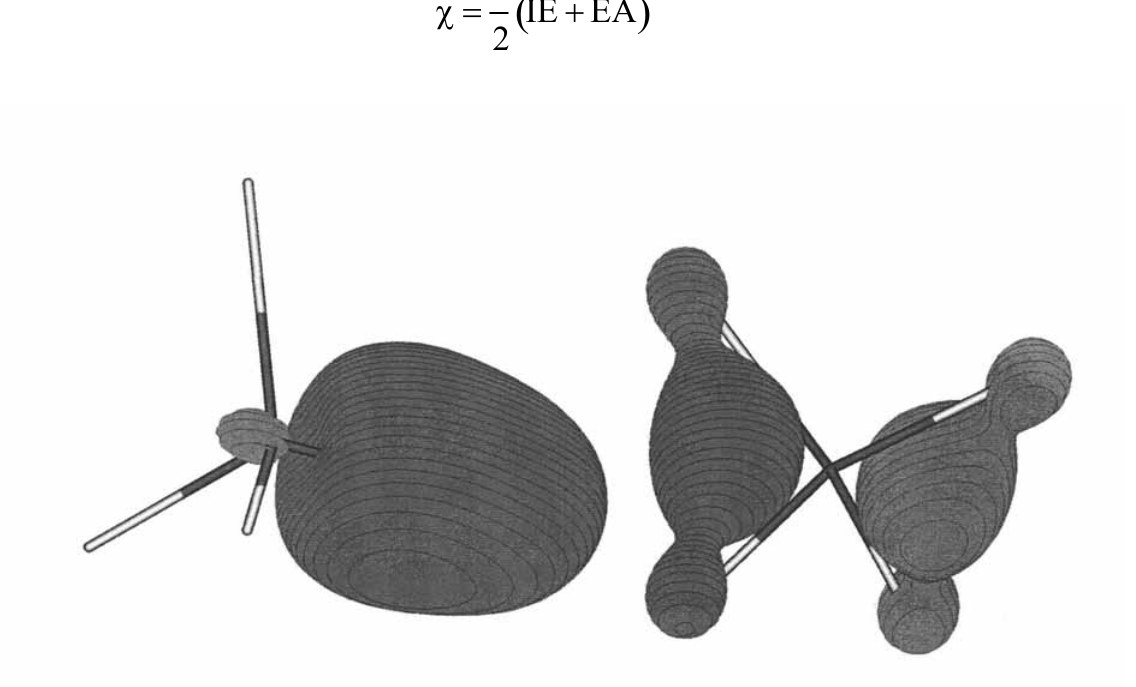
Figure 3 : Delocalized Hartree Fock versus Localized Orbitals : one of the triply degenerate HOMO orbitals of methane versus a CH bond orbital. Electron density plot (Hartree Fock STO-3G/Boys localization procedure [25]) obtained with the software package [26]